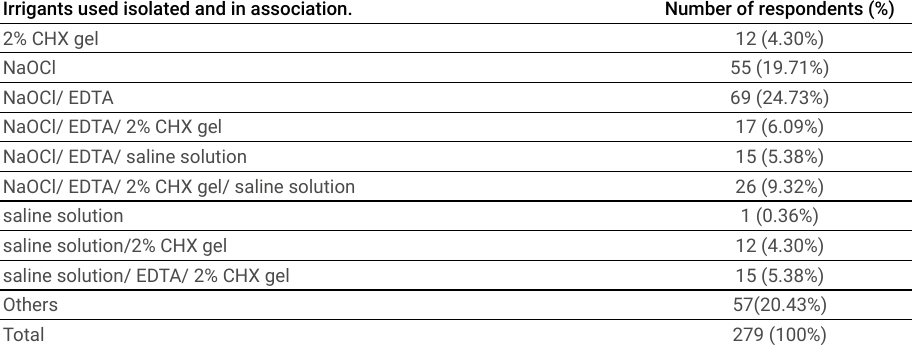
Table 2. Irrigants used in isolation or combined. Irrigants used isolated and in association.